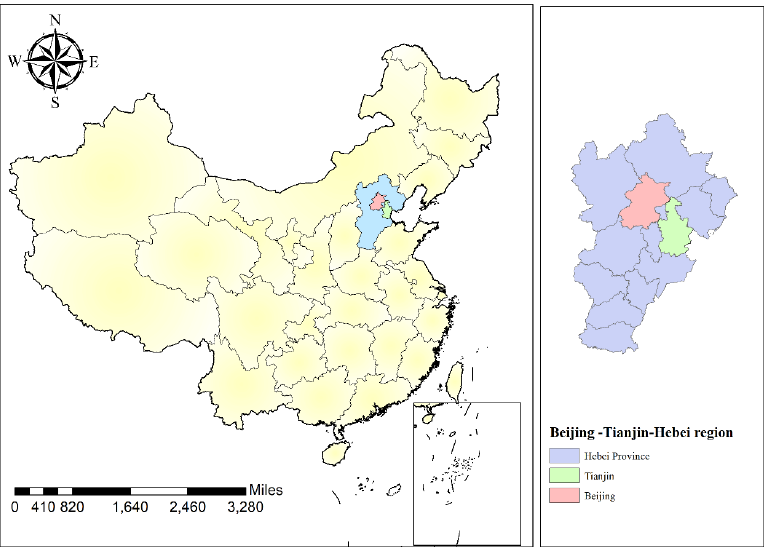
Figure 1. Geographical location of Beijing–Tianjin–Hebei